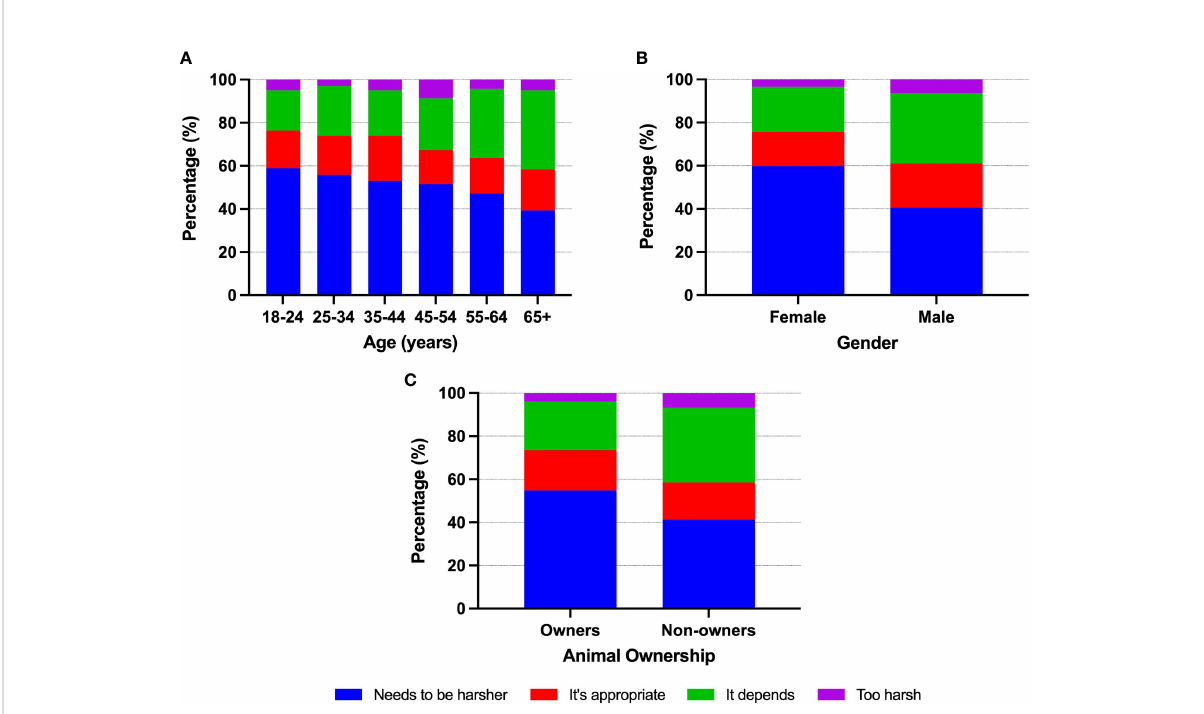
FIGURE 8 Response percentages showing the signi fi cant relationship between opinion on sentences for animal cruelty and the demographic variables of age (A) , gender (B) and animal ownership (C) ; p-value < 0.05. “ Previous research has shown that the average penalty for this type of offence [deliberate animal cruelty causing serious harm] is 4 months imprisonment; do you think this is appropriate and suf fi cient? ”